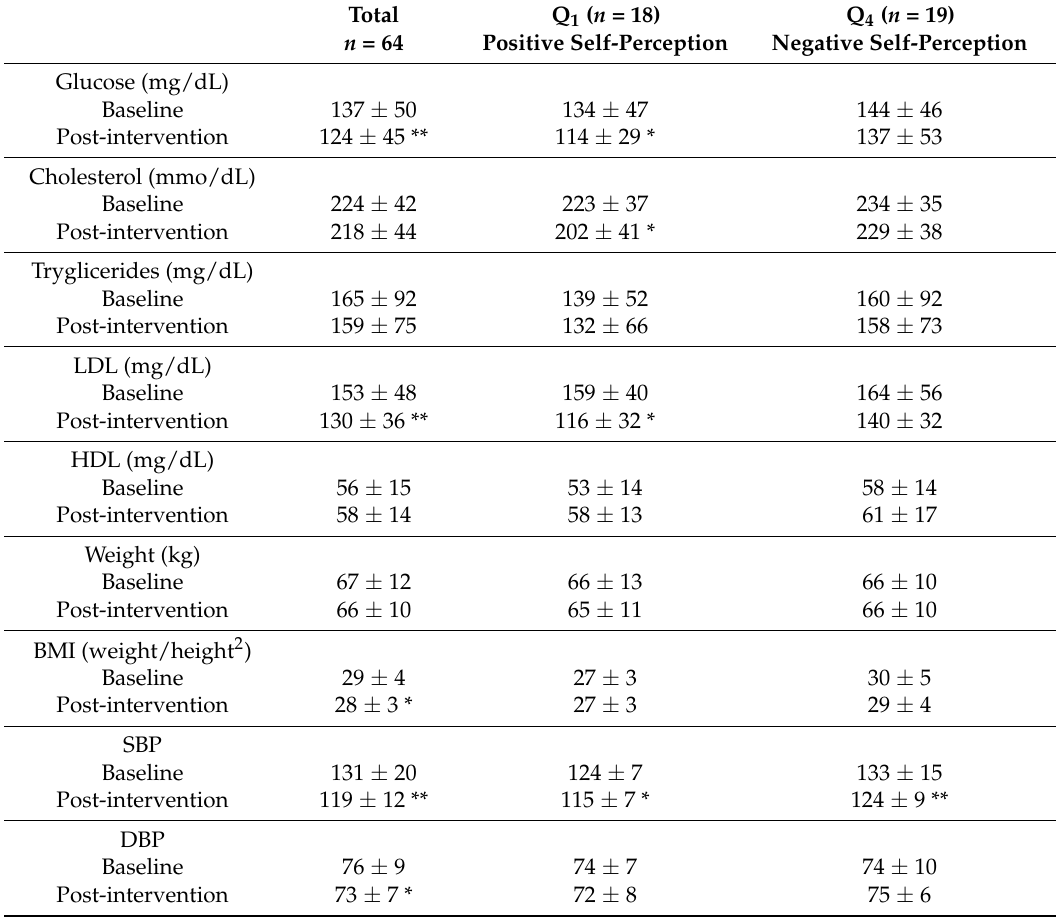
Table 5. Effect of healthy aging program linked to positive and negative self-perception old